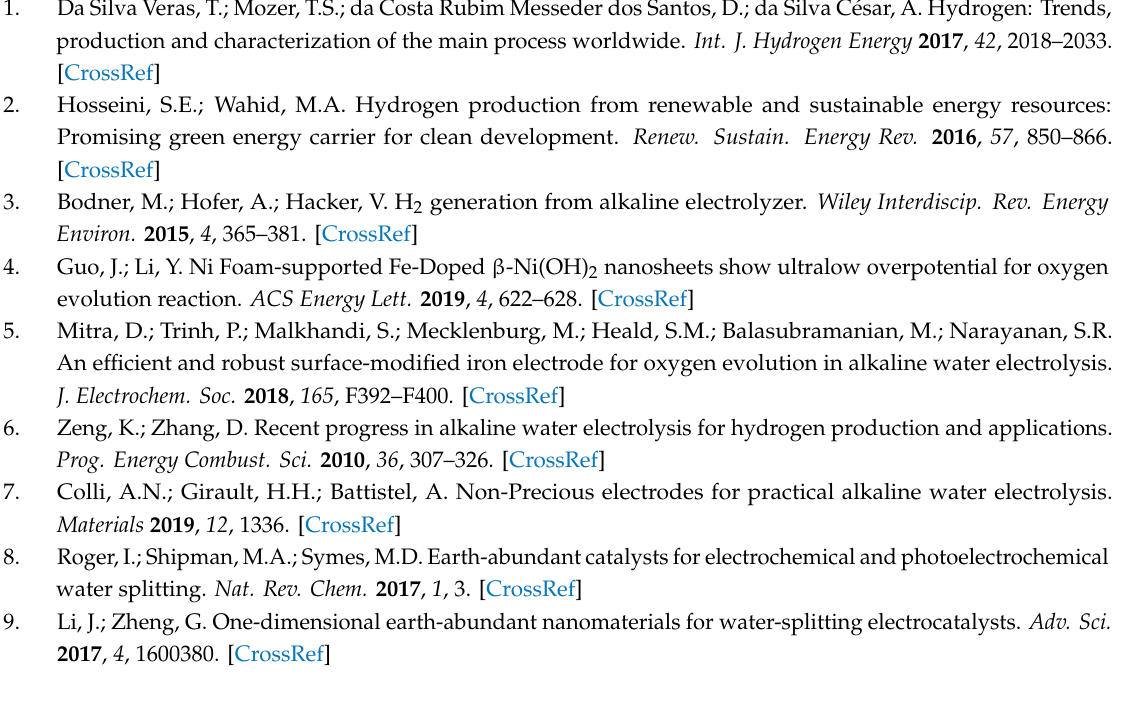
Figure S1: Cyclic voltammograms recorded during sweeping the potential from 0.15 to 0.25 V vs. Ag / AgCl with di ff erent scan rates in an aqueous solution of 1 M KOH for Mn-Co film synthesised in solutions of Mn / Co 2:4 mM (a), 2:6 mM (c), and 2:8 mM (e) for 200 mC. Corresponding linear approximation of the capacitive currents versus scan rate obtained from cyclic voltammograms for Mn-Co film synthesised in solutions of Mn / Co 2:4 mM (b), 2:6 mM (d), and 2:8 mM (f) for di ff erent deposition charges. Figure S2: Synthesis graphs recorded during the potentiostatic deposition of Mn / Co oxide / hydroxides at − 1.1 V vs. Ag / AgCl in aqueous solutions of di ff erently concentrated Mn(NO 3 ) 2 · 4H 2 O and Co(NO 3 ) 2 · 6H 2 O with electropolymerisation time limited by a charge of 200 mC. Figure S3: Optical microscopy image of the as-deposited and after-alkaline-treatment-in-1 M-KOH Mn-Co film on nickel foam. Figure S4: SEM images of Mn-Co film synthesised in an aqueous solution of Mn / Co 2:4 mM for 60 mC (a), 2:4 mM for 120 mC (b), and 2:4 mM 200 mC (c) and 2:6 mM 200 mC (d) on nickel foam. Figure S5: SEM images of Mn-Co film synthesised in aqueous solution of Mn / Co 2:4 mM for 60 mC (a) and 2:8 mM for 200 mC (b) on nickel foil. Figure S6: SEM images of Mn-Co film synthesised in an aqueous solution of 4 mM Co(NO 3 ) 2 · 6H 2 O (a) or 4 mM Mn(NO 3 ) 2 · 4H 2 O and 2 mM Co(NO 3 ) 2 · 6H 2 O on nickel foam for 200 mC. Figure S7: Linear sweep voltammetry profiles (a) and corresponding Tafel plots (b) of Mn-Co film synthesised in solutions of Mn / Co 2:4 mM, 4:2 mM, and 0:4 mM on nickel foam measured in Ar-purged 1 M KOH. Figure S8: Linear sweep voltammetry profiles of nickel foil and Mn-Co film synthesised in a solution of Mn / Co 2:8 mM for 60 and 120 mC on nickel foil. Table S1: Comparison of catalyst based on Mn and / or Co transition metals synthesised electrochemically for OER activity available in the